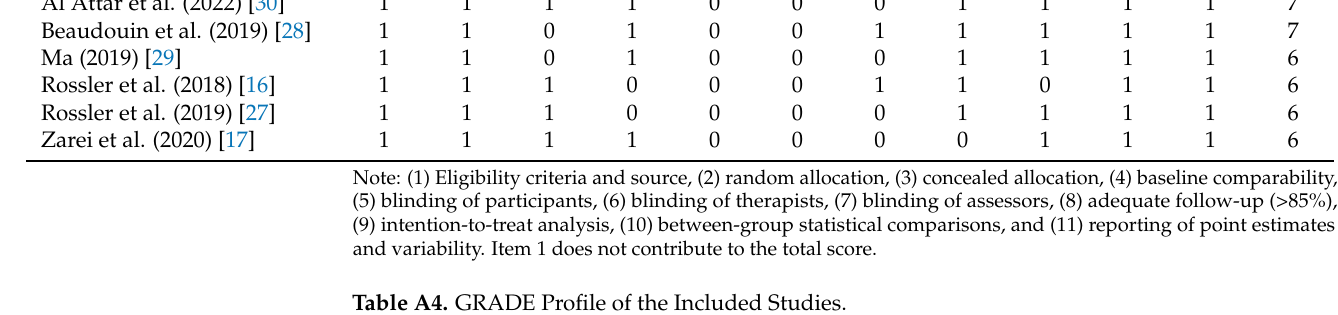
Table A4. GRADE Profile of the Included